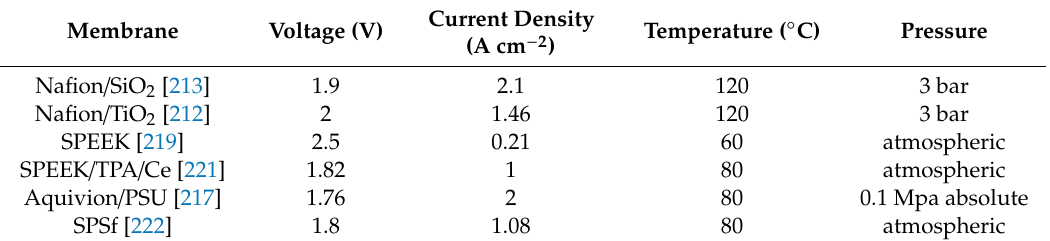
Table 5. Summary of PEM electrolyser best performance using composite